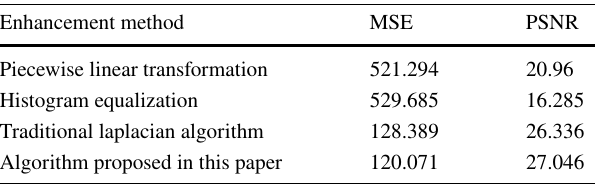
Table 1 Image quality evaluation after enhancement by different Table 2 Image quality evaluation index after different filtering